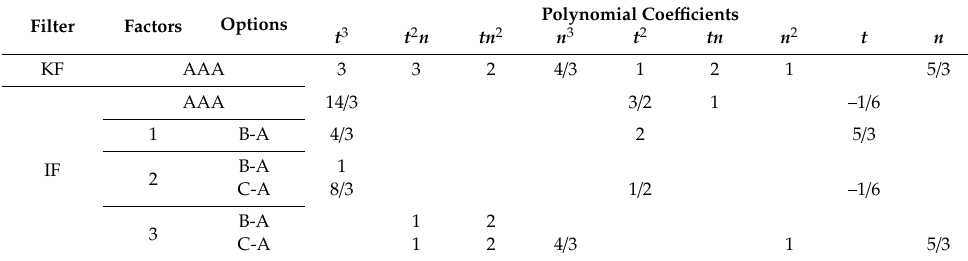
Table 5. Polynomial coe ffi cients of scalar multiplication operation.